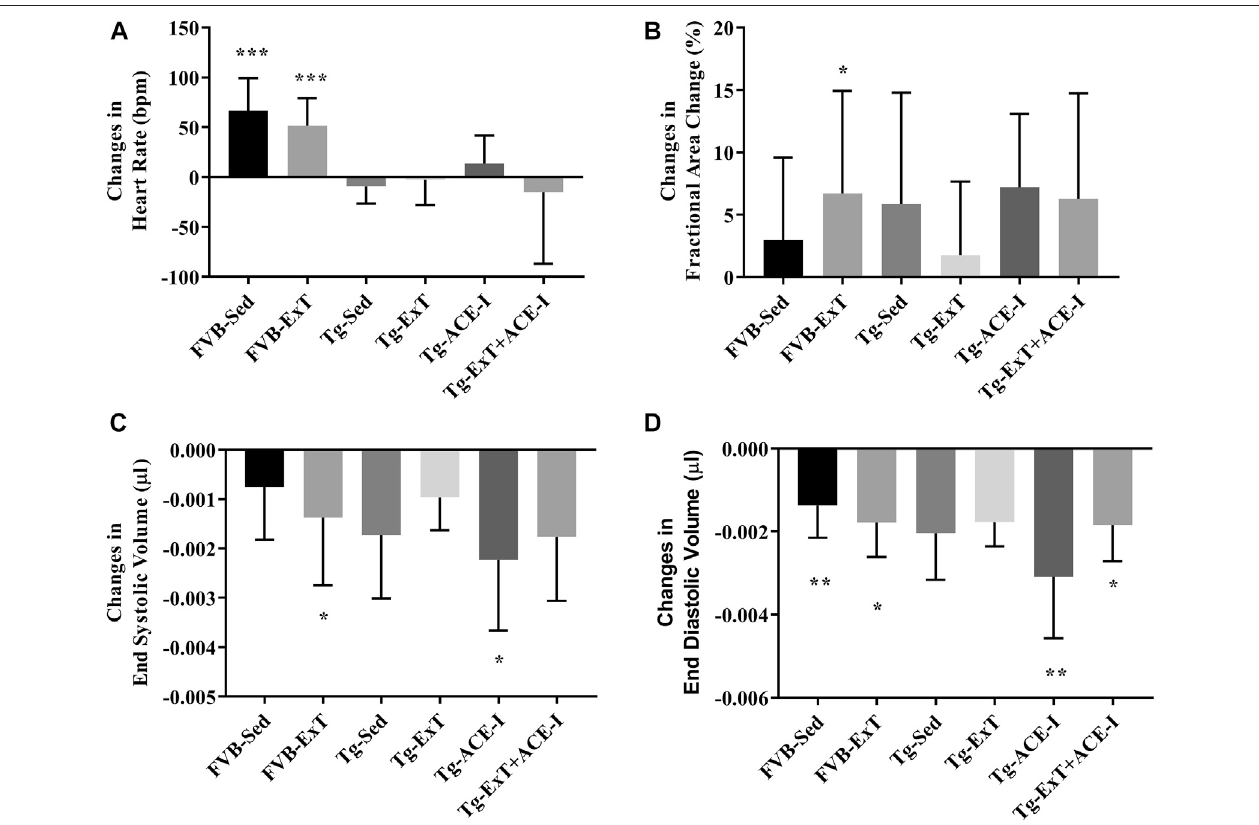
FIGURE 3 | Cardiac reserve under dobutamine stimulation. Chronotropic response to dobutamine was observed in healthy controls, while no chronotropic accelerationwasnotedinTg α q*44miceatthemeasuredstageofHF (A) .Cardiac inotropicresponsetodobutaminewasobservedinFVB-exercised(asincreasedFAC) and increased contractility to stimulation was noticed in FVB-exercised and sedentary Tg α q*44 mice with applied therapy (B, C) . EDA profoundly decreased after stimulationinsedentaryandexercisedFVBmiceandinsedentary andexercisedTg α q*44micewithappliedtherapy (D) .Valueswerepresentedasmean ± SD; n (cid:1) 6 – 12. * p < 0.05, ** p < 0.01, and *** p < 0.001 for dobutamine stimulation vs. basal condition. Statistics: t test for comparisons between basal values as compared to values obtained under dobutamine stimulation for each